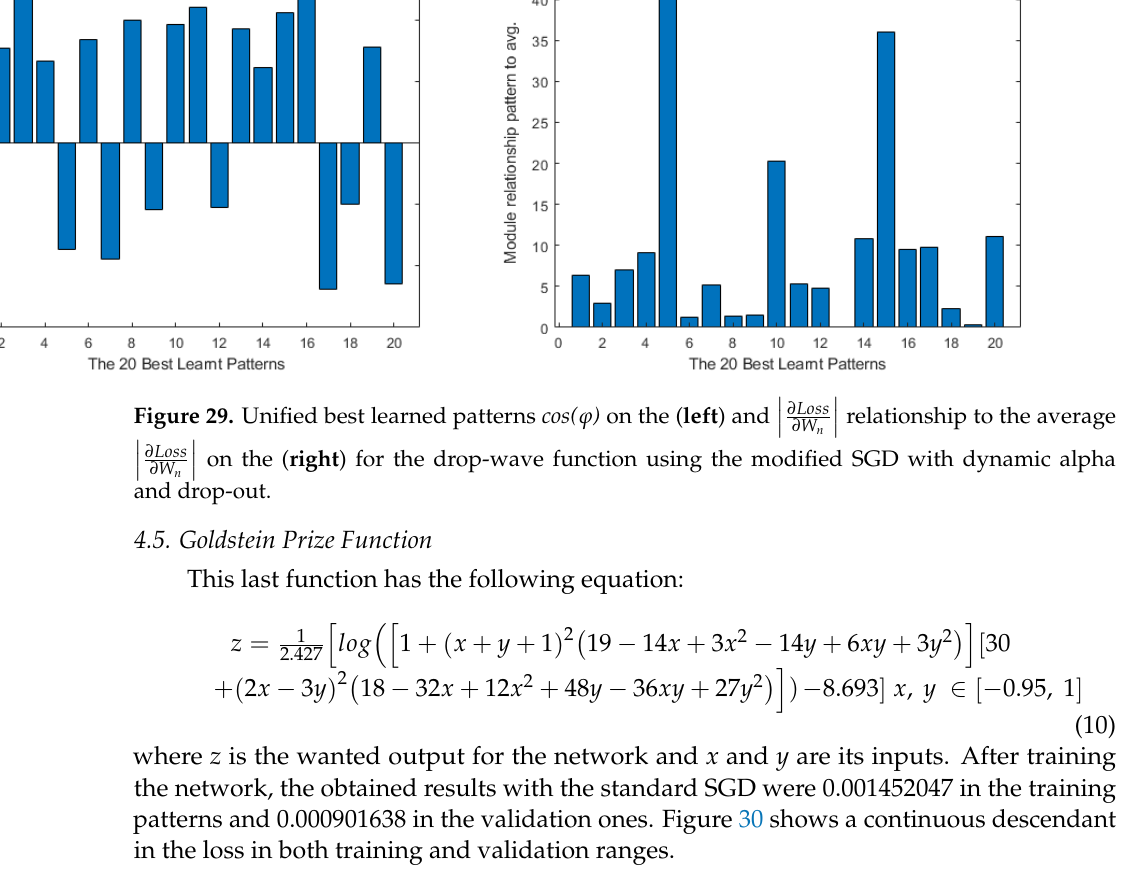
Figure 30. Average loss on training patterns in blue and validation patterns in orange for Standard SGD of Goldstein Prize function. On the dynamic alpha and drop-out, the results were 0.001287429 in the training pat- terns and 0.002754883 in the validation patterns. Figure 31 shows a similar behavior to the normal SGD case, with a noisier state of the validation loss in the final epochs of training.